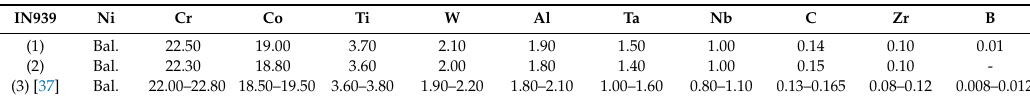
Table 1. IN939 main chemical composition of the IN939 in weight percent (wt. %): (1) chemical composition of the used powder provided from the supplier; (2) semi-quantitative analysis obtained by EDS analysis except for C determined by combustion infrared analysis of the used powder; (3) standard chemical composition range of cast IN939 alloy, data from